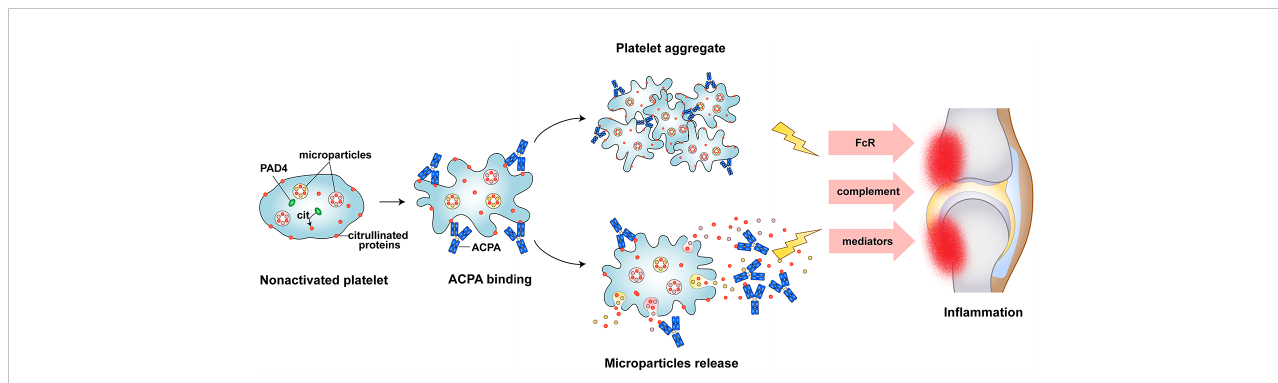
FIGURE 5 Schematic picture of platelet as a source of autoantigens and persistent in fl ammation in RA. Autoantibodies ACPA recognized citrullinated proteins in platelet, result in platelet activation, aggregation, and microparticles releasing. This will further lead to citrullinated proteins exposure to the immune cell, triggering of ACPA production and contribute to the persistent in fl